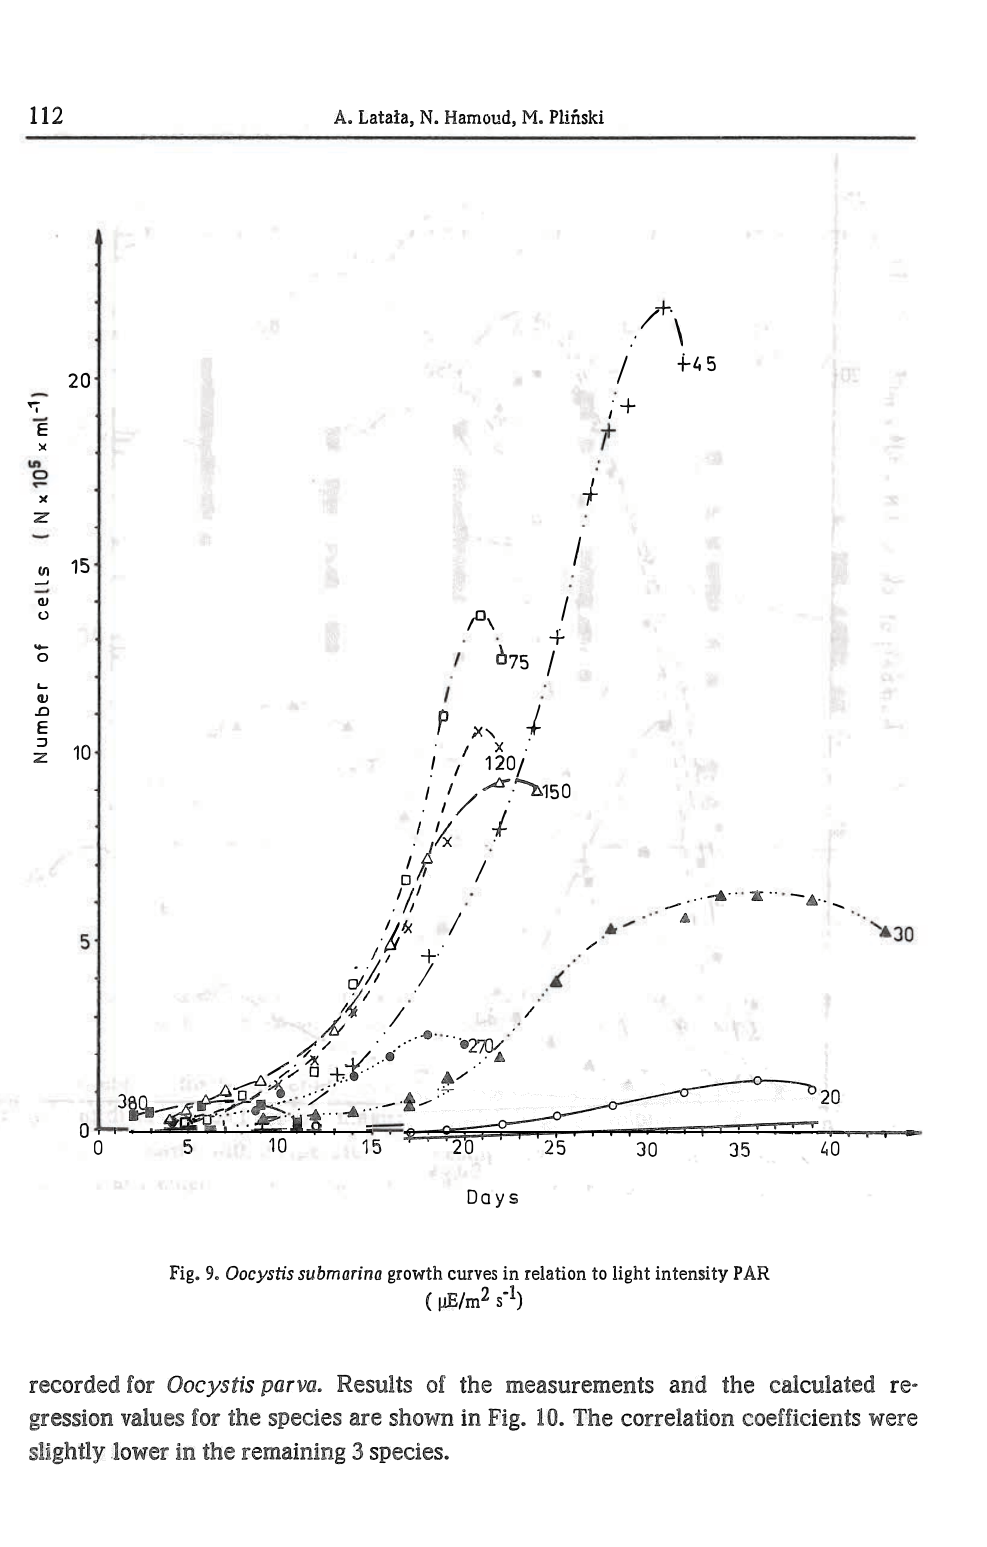
the. species are shown in Fig. 10. The correlation coefficients were the remaining 3